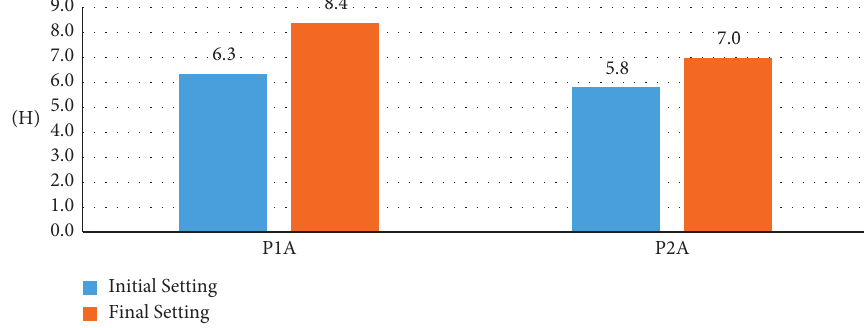
Figure 4: Influence of the SiO 2 :Na 2 O ratio on the setting time.